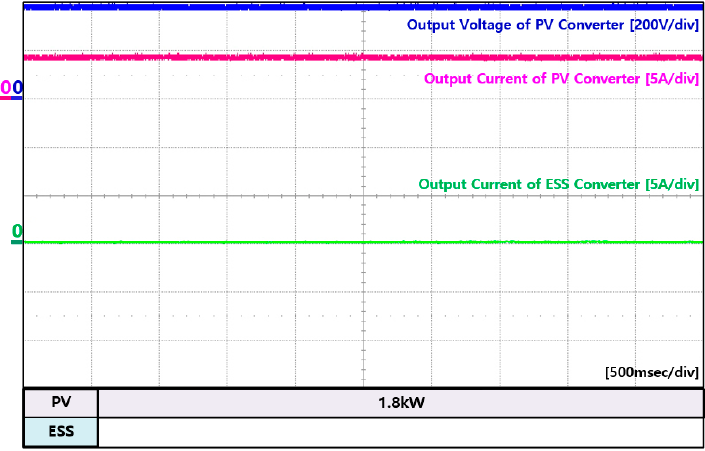
Figure 21. Experiment waveforms of PV converter and ESS converter in mode 3.